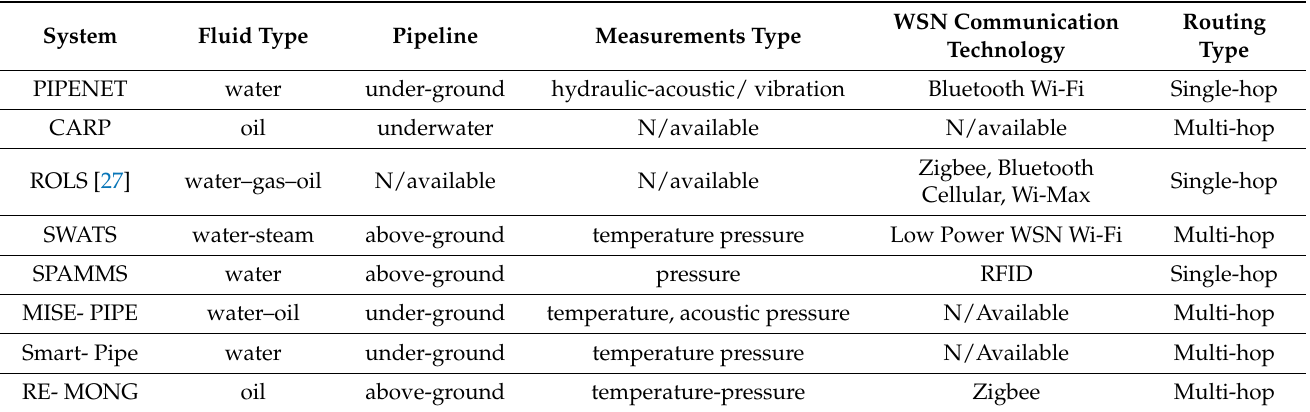
Table 2. WSN Pipeline Leak Detection